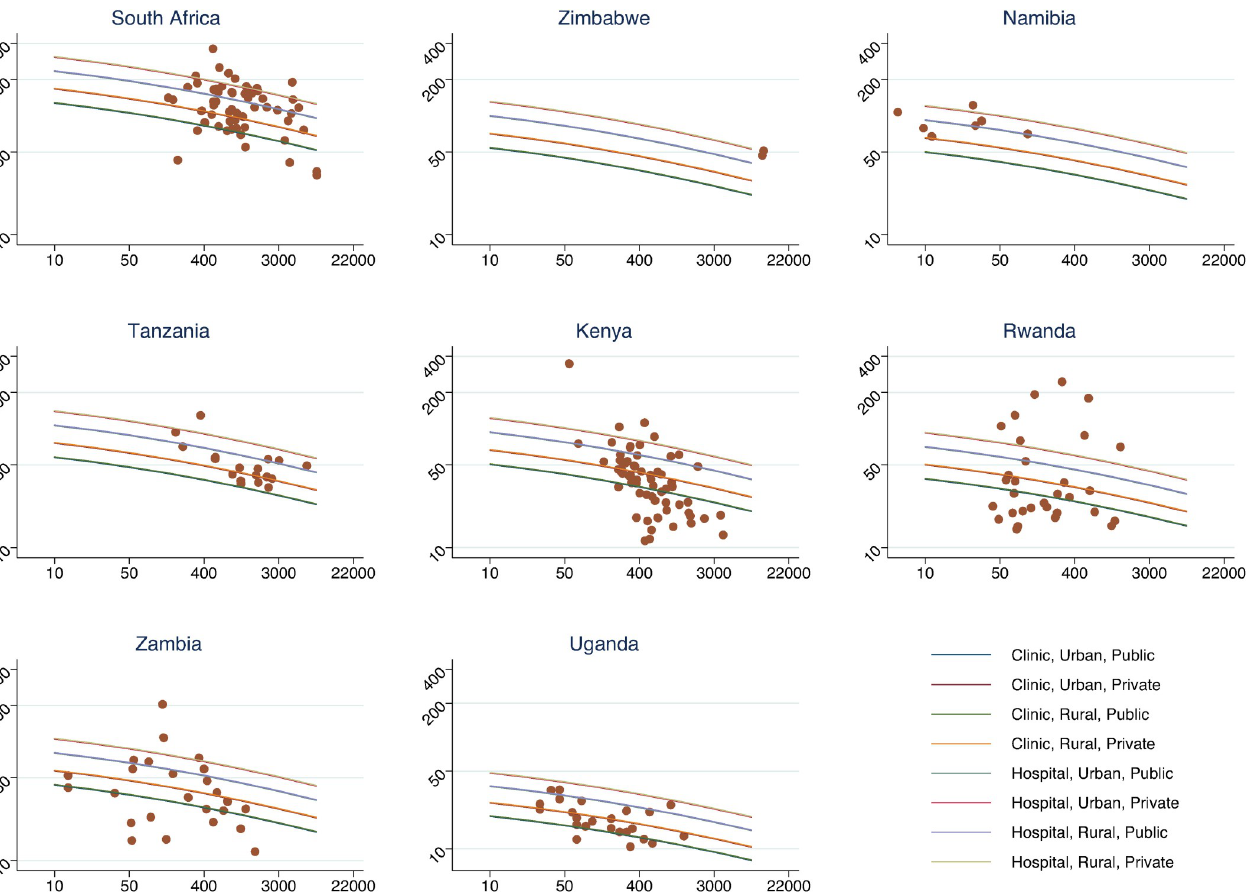
Fig 1. VMMC unit cost curves by country. Notes. Each panel presents the estimated cost curves for each service delivery platform defined as the combination of facility type, urbanicity, and ownership for each country, as indicated by the color guide. The panels also present the observed values of unit costs for each